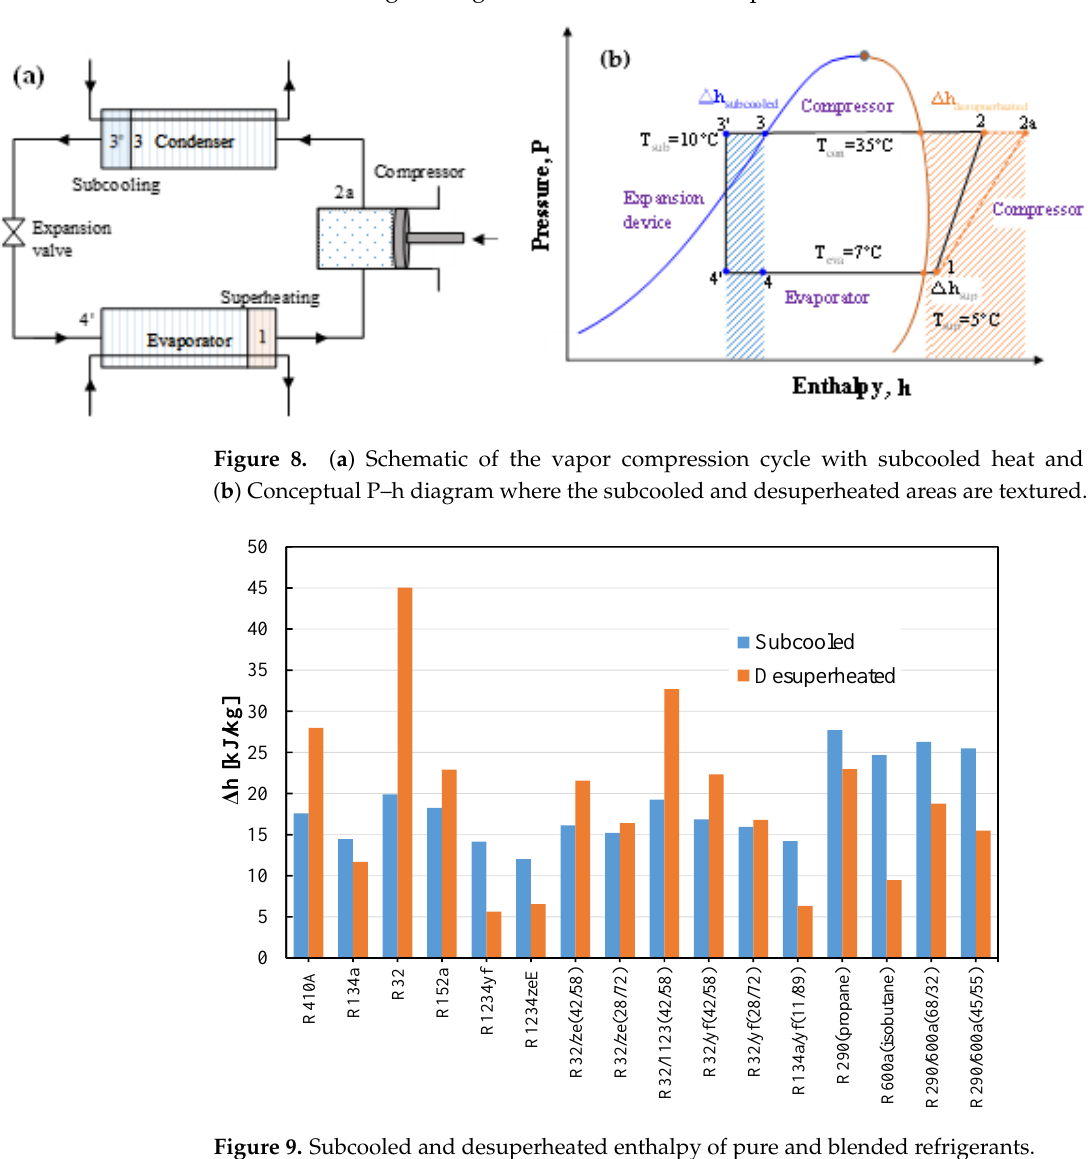
Figure 10. COP and volumetric capacity of pure and blended refrigerants.